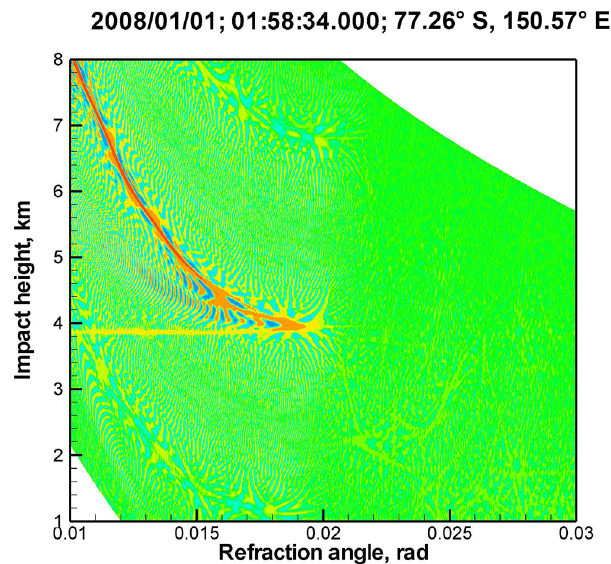
Figure 3. Reflection over ice and snow in